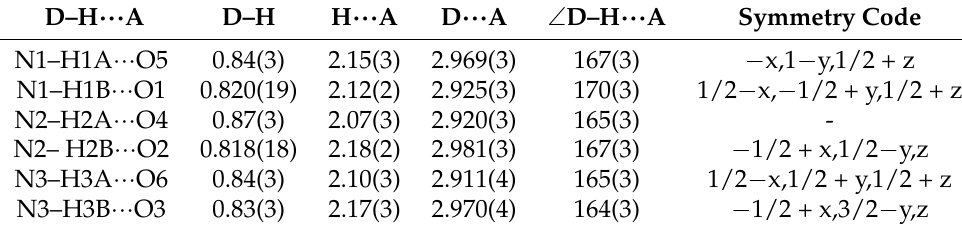
Table A3. The geometry of hydrogen bonds (Å, o ) for [C(NH 2 ) 3 ][Cu(HCOO) 3